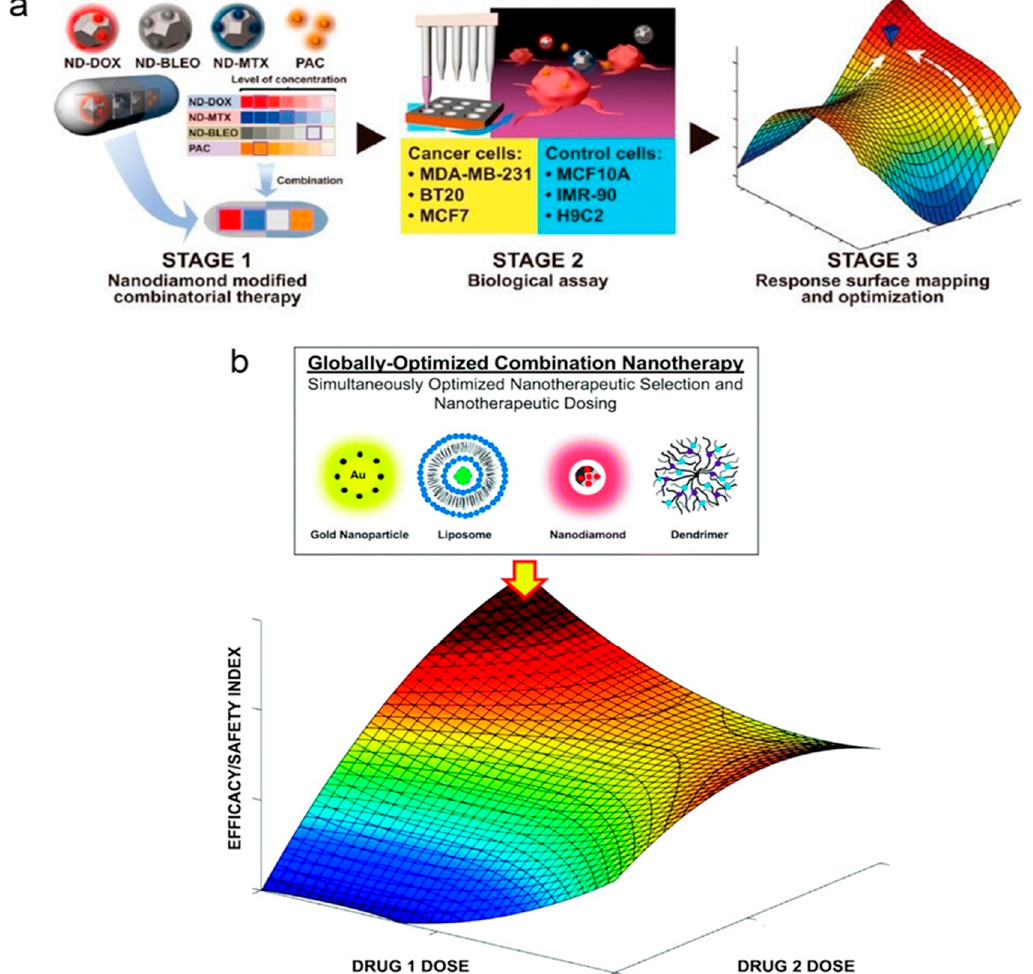
Figure 2. ( a ) The structure of feedback system control. Stage 1: Loading of bleomycin (BLEO), mitoxantrone (MTX), and DOX onto NDs was performed using physisorption, forming uniform and stable colloidal solutions, and combinations were designed. Stage 2: Using customized liquid handling robotic procedures, the drug combinations were applied to several types of cancers and control cells. The viability of cancer cell lines and control cell lines were utilized to feed into the informatics system. Stage 3: The informatics system provided cellular response surfaces by regression analysis with the customized statistic model on the combinations. Global combinatorial optimization was performed by differential evolution on the surface of the therapeutic window. Then the predicted randomized and optimum combinations were experimentally verified to confirm mapping accuracy [50]. ( b ) Make use of AI for nanomedicine optimization. A schematic doublet nanotherapy drug interaction map is present. Using rationally designed combination nanotherapy arrangements for initial calibration experiments